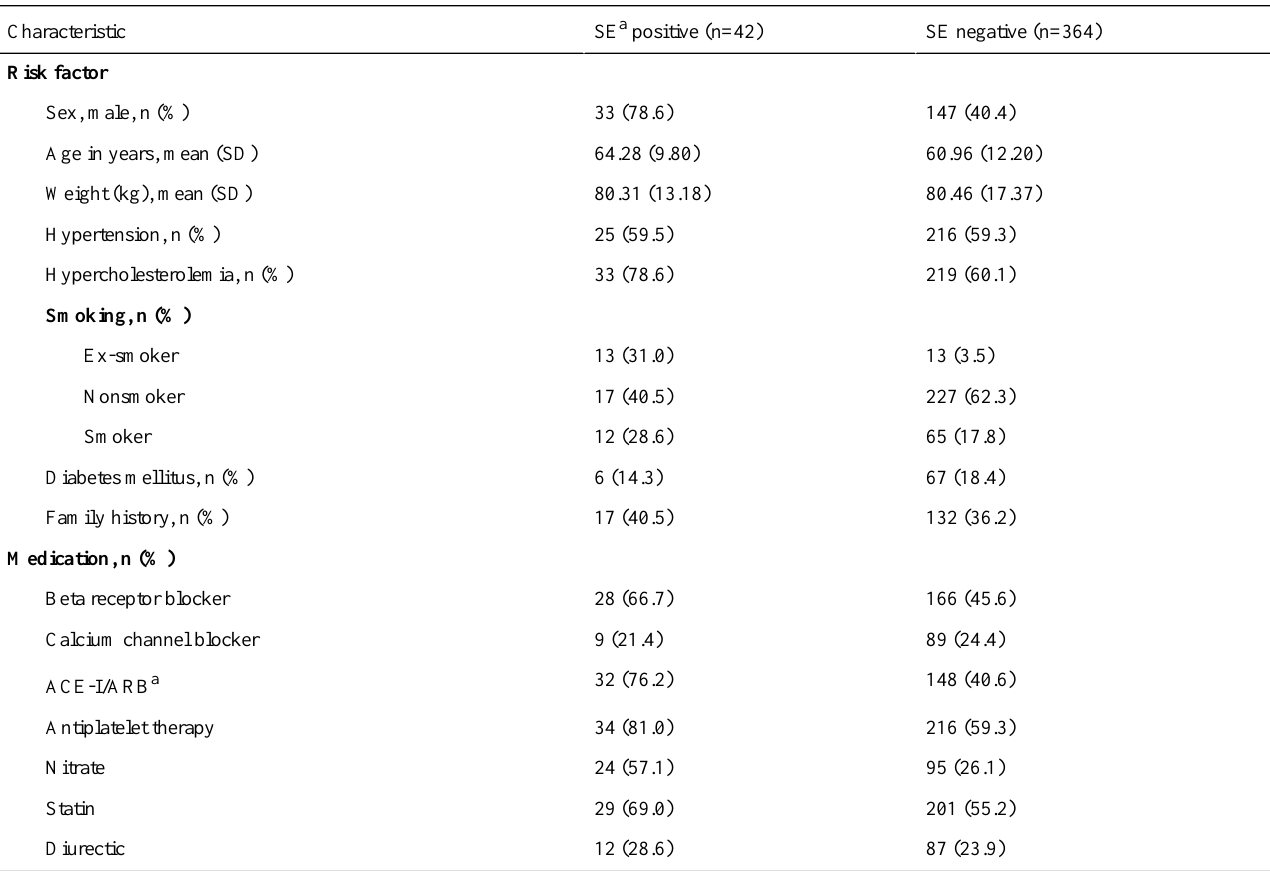
Table 2. Characteristics of patients and their stress echocardiography outcome in those with no prior ischemic heart